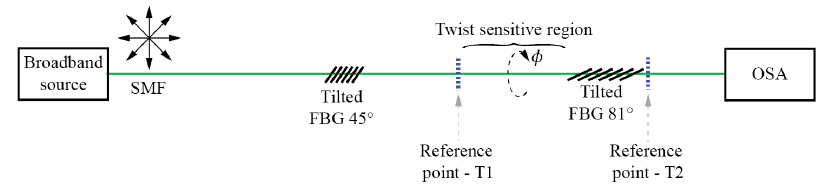
Figure 23. TFBG setup for rotation measurement.